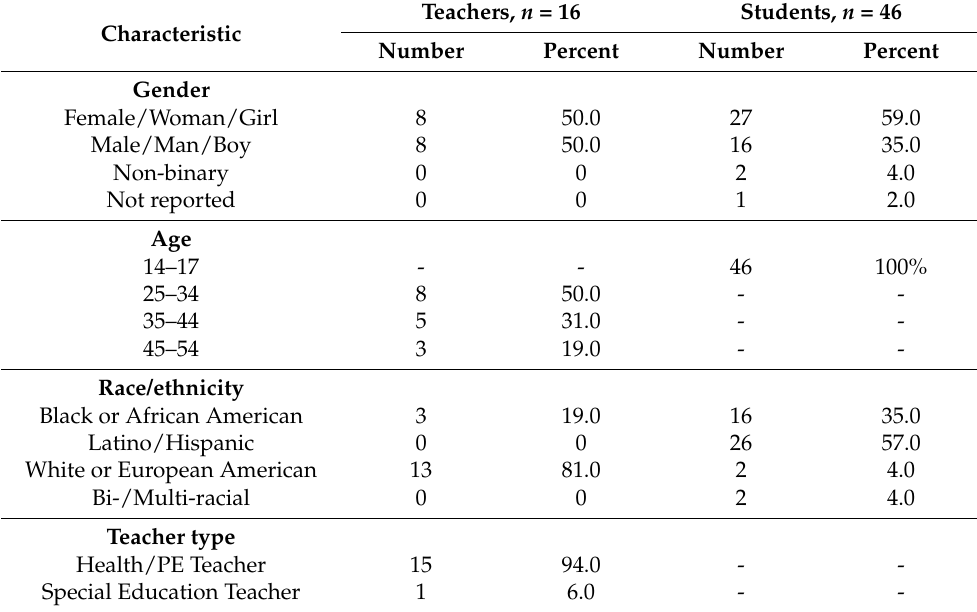
Table 2. Teacher and student demographic